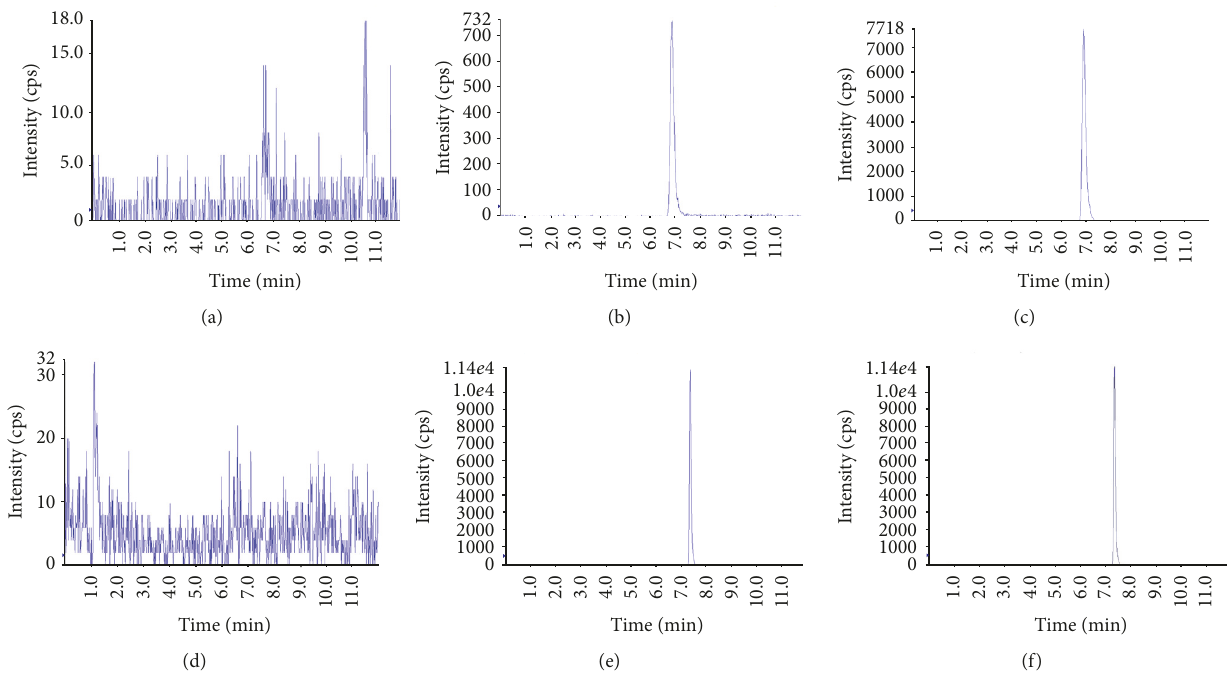
Figure 2: MRM chromatograms of the specimens. Representative MRM chromatograms of (b) lenvatinib (LOD; 0.96 ng/mL), (c) lenvatinib (LLOQ; 9.6 ng/mL), (e) propranolol as an internal standard, (a), (d) blank samples (plasma), and (f) zero sample (blank sample spiked with internal